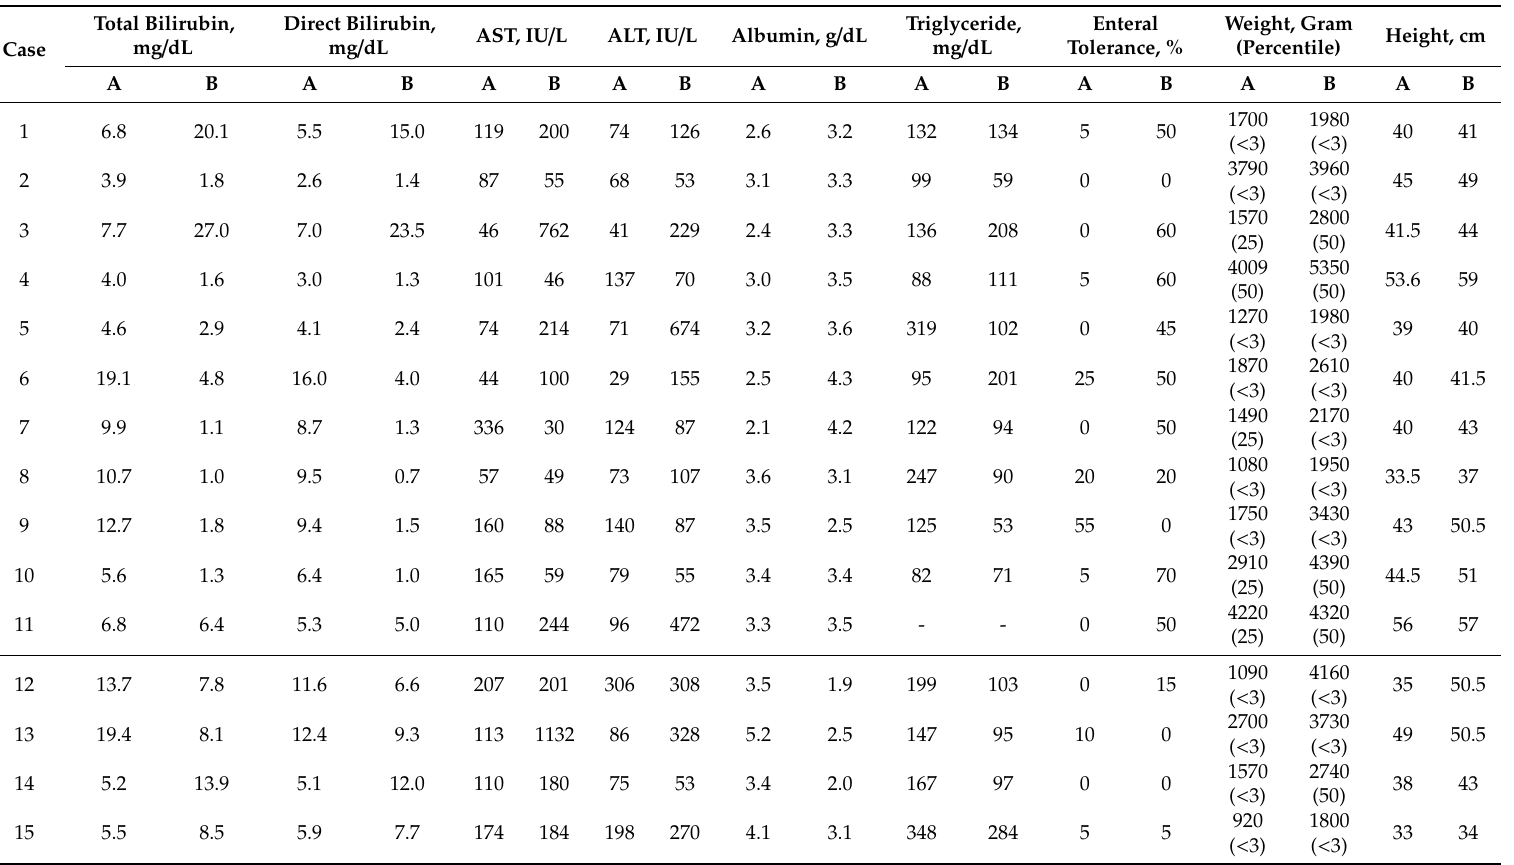
Table 2. Biochemical data and growth of infants at the initiation and cessation of fish oil